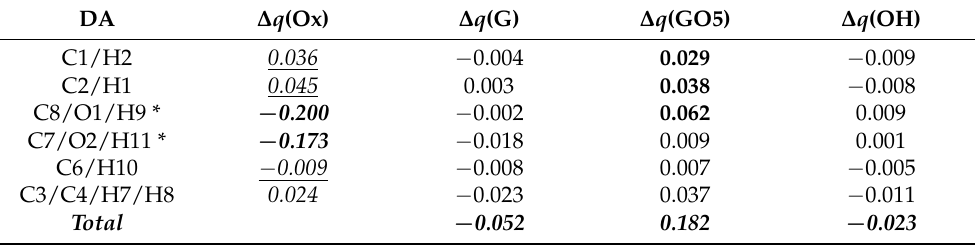
Table 5. Change in partial charge ∆ q of each atom group of a dopamine (AA) from the neutral state to the oxidized state ( ∆ q (Ox)), and the bound state with the pristine graphene ( ∆ q (G)), GO5-para (bold) and their adjacent atom groups (underlined) are highlighted. For the bound molecules, the ∆ q of atom groups losing more than 0.025 electrons to the substrate via adsorption (bold) are highlighted. Oxidation sites are labeled by ‘*’.